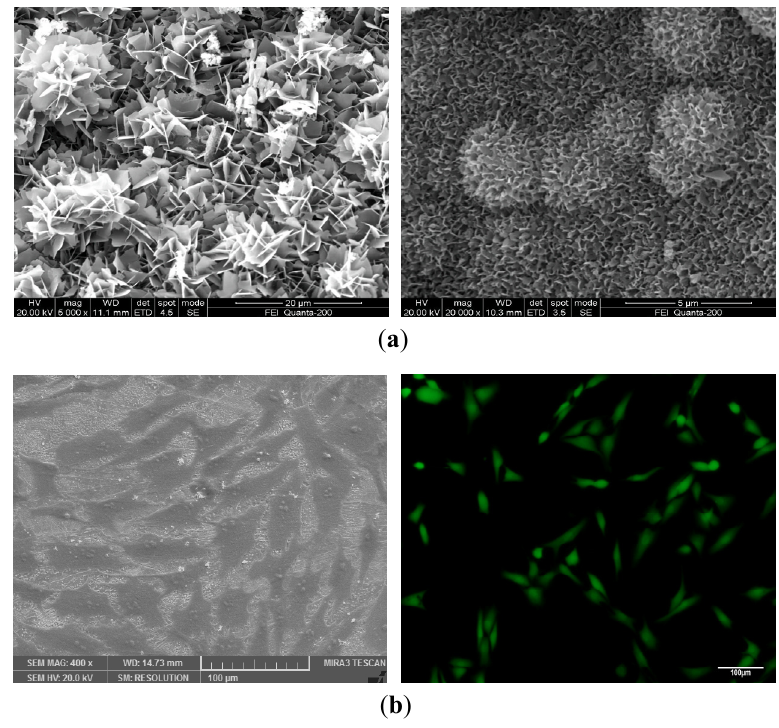
Figure 2. ( a ) Surface morphology of TCP ceramic scaffold after immersing in SBF;